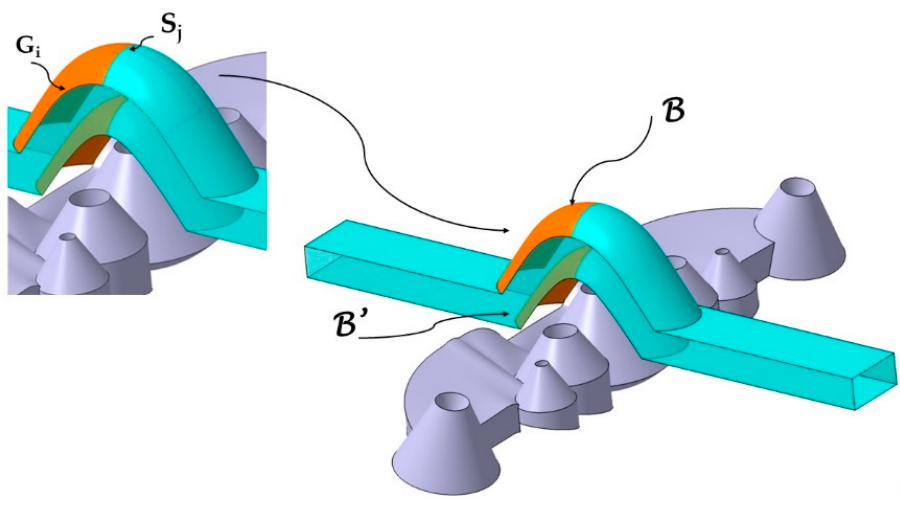
Figure 6. Generating curve S j.